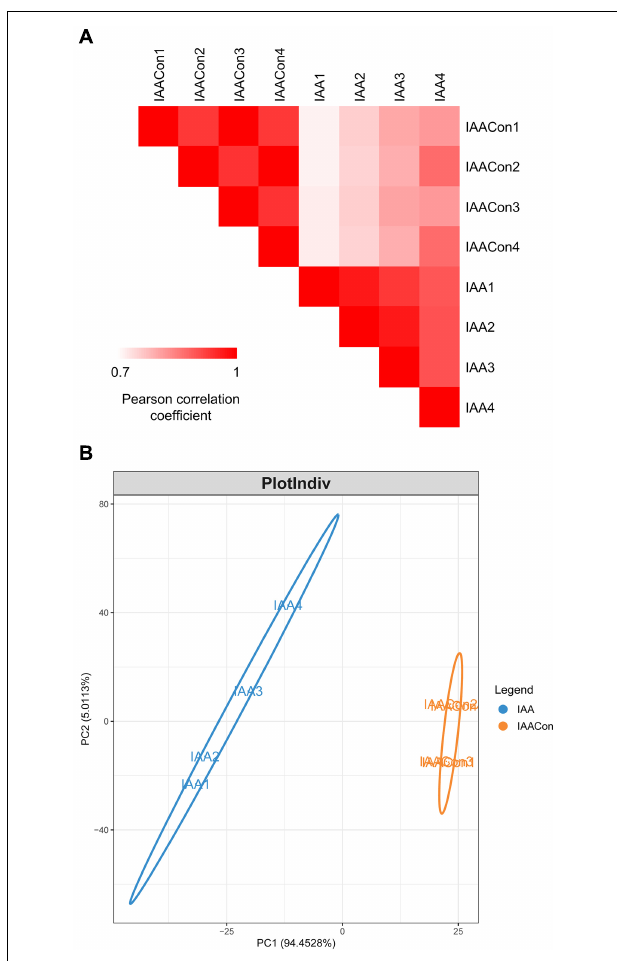
FIGURE 3 | Overview of proteome data. (A) Pearson correlation coefficients for pair-wise comparisons of the IAA and IAACon proteome data. (B) PLS-DA of proteome data from IAA and IAACon